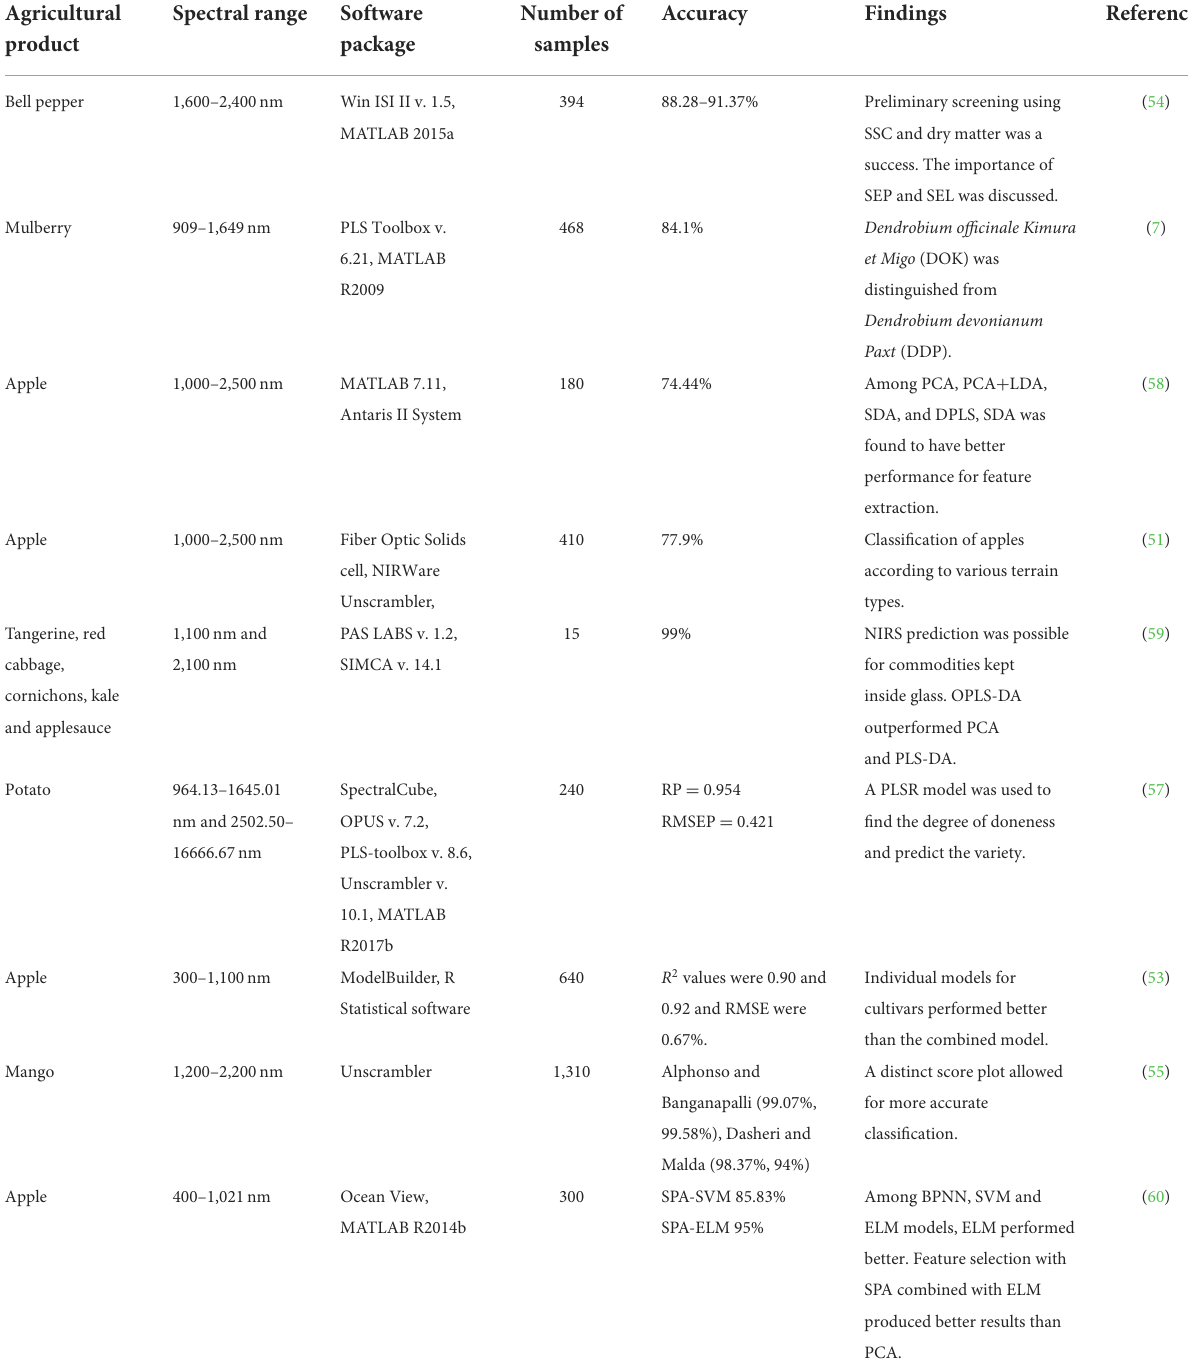
TABLE 3 Summary of variety and cultivar identification for various agricultural products using